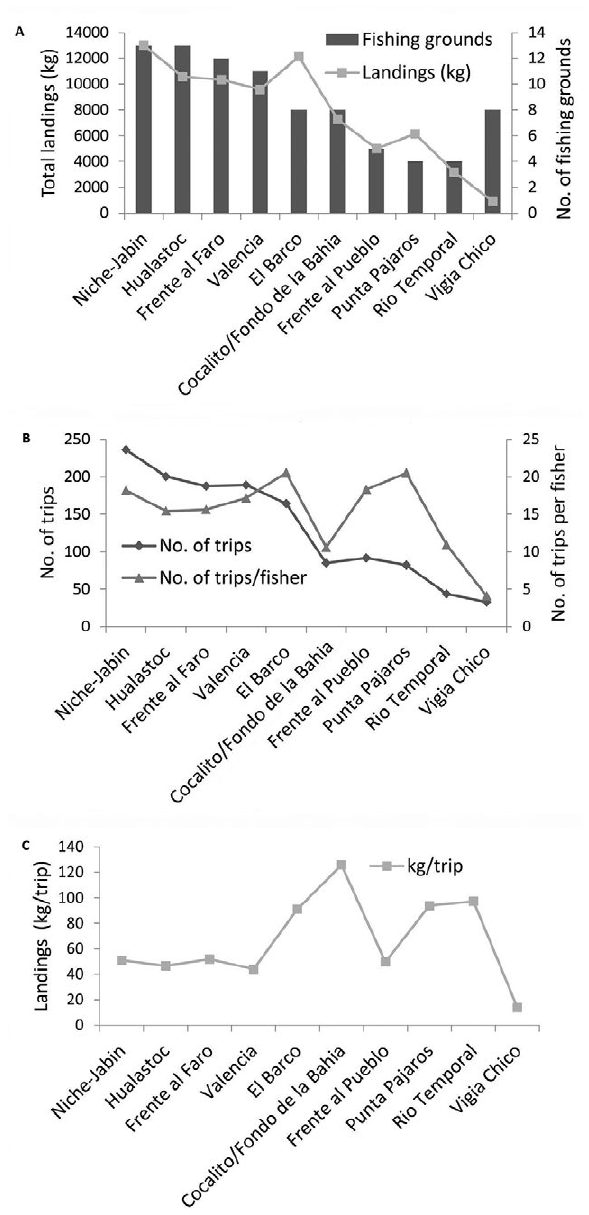
Fig. 3. – A, average total landings of spiny lobster (kg) for the four seasons by fishing area and the number of fishing grounds within each fishing area; B, average total number of fishing trips and aver- age number of trips per fisher for the four seasons by fishing area; C, average total landings of spiny lobster (kg) per trip for the four seasons by fishing